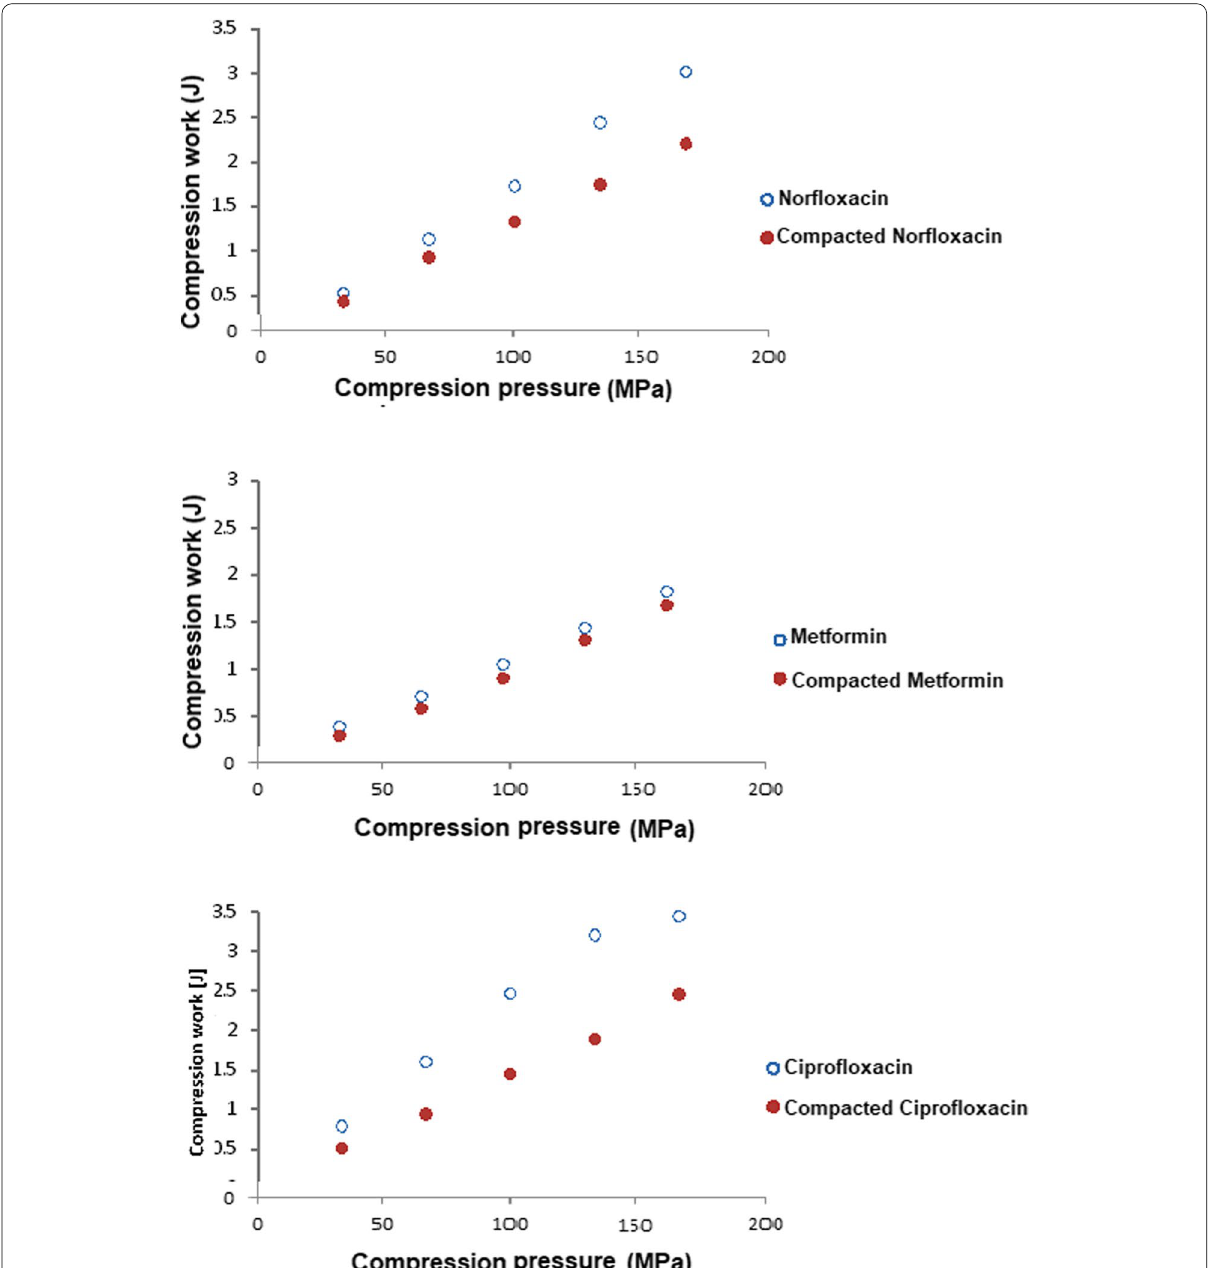
Fig. 5 The compression work, calculated based on the F-D curves, for non-compacted and compacted drugs comprising norfloxacin, metformin, and ciprofloxacin at different compression